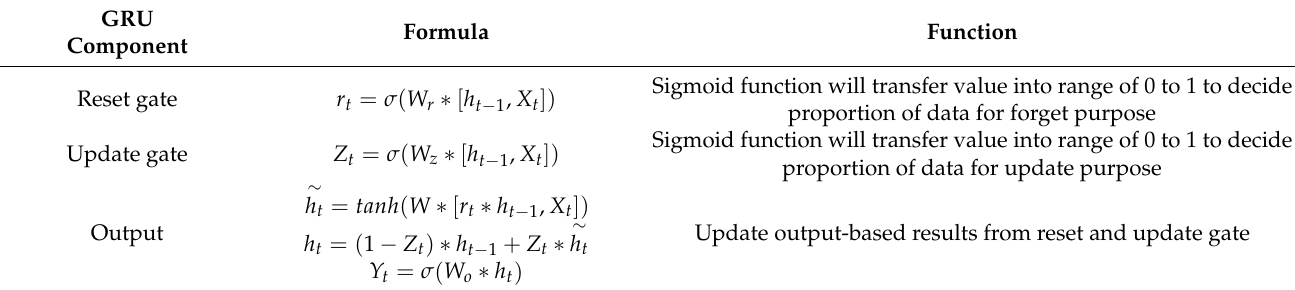
Table 2. Gate recurrent unit (GRU)